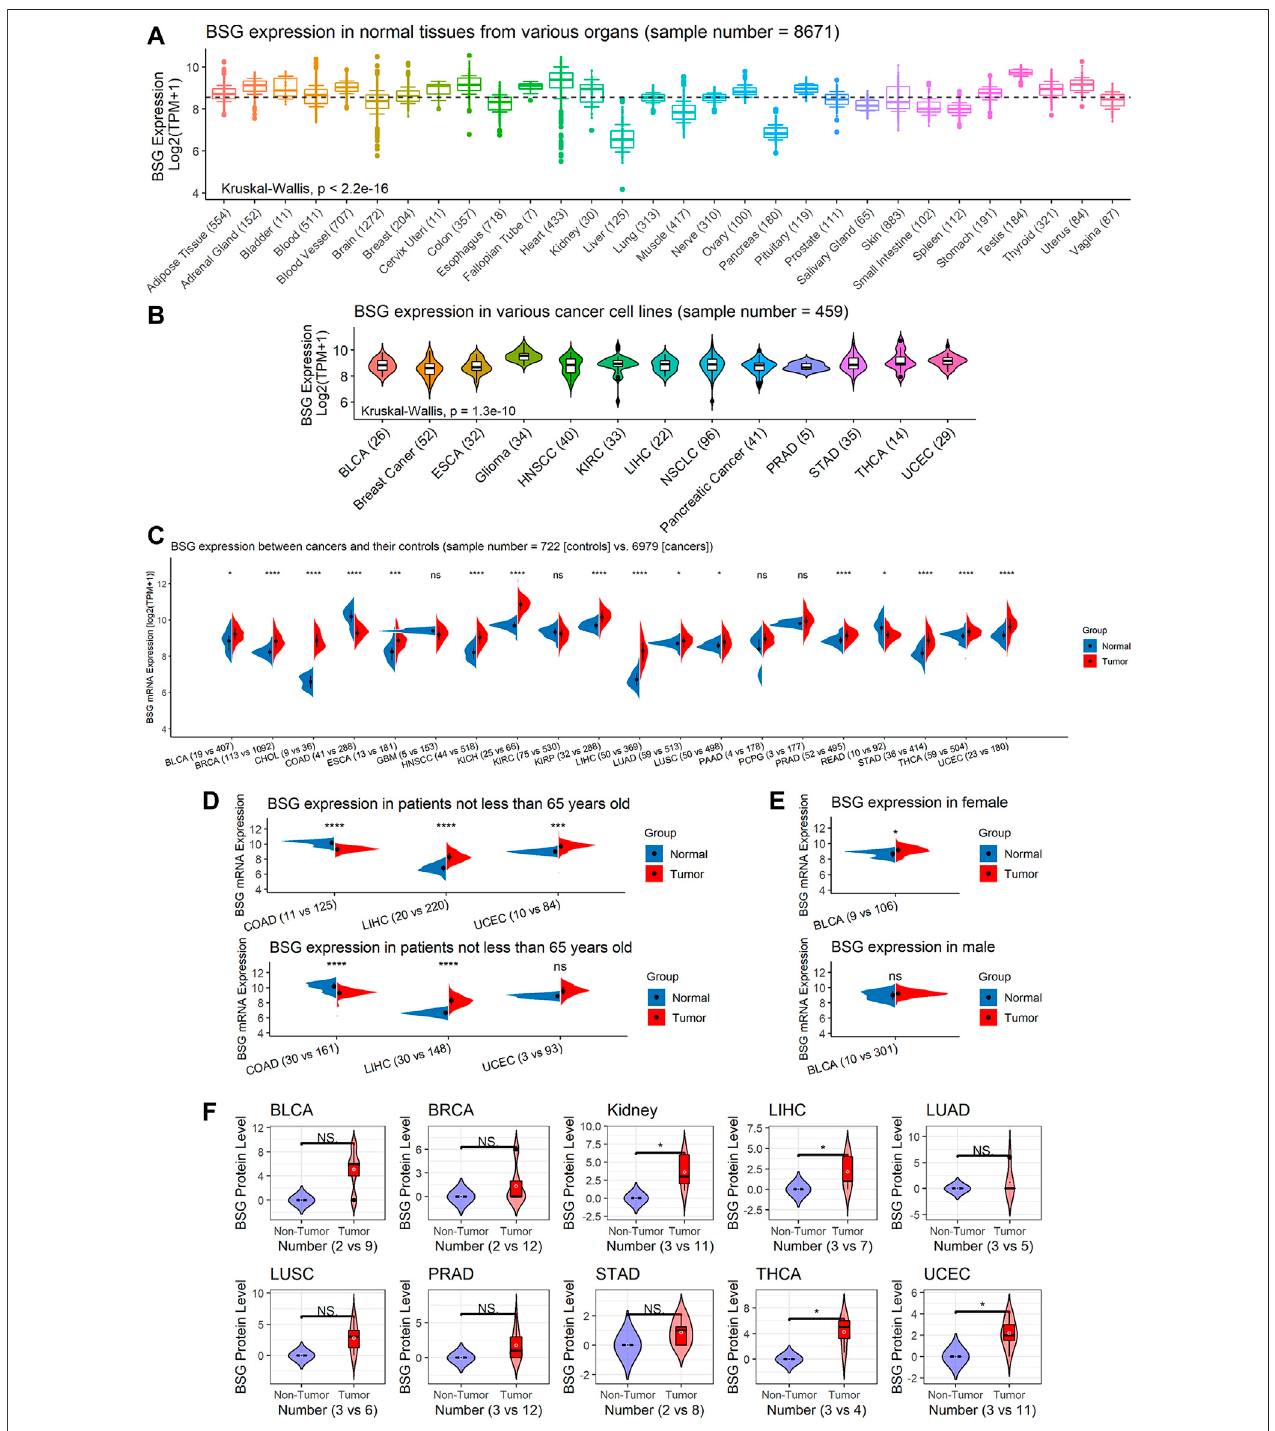
FIGURE 2 | BSG expression in normal tissues and pan-cancer at mRNA and protein levels. (A) Distinct BSG expression in various normal tissues of humans; the dashed linerepresents theaveragevalue(equalingto8.549)ofBSGexpressioninallnormaltissuesshowninthispanel. (B) DifferentBSGexpressionsinvarious cancer cell lines ofhumans. (C) DifferentBSG expressions between cancer tissueswith their normal tissues. (D – E) Hierarchical analysis ofBSGexpression differencesin some cancers and their control tissues. (F) Elevated BSG levels in several cancers were validated at the protein level. In (A,B) , the value in parentheses represents the numberofsamples.In (C – E) ,thetwovalues(e.g., “ n=19vs.407 ” forBLCA)inparenthesesrepresentthenumbersofcontrolsandcancers,respectively.In (C – F) ,each p -value in this fi gure is based on the Wilcoxon rank-sum test, and then p -values in (C – E) are adjusted by multiple comparisons with the false discovery rate method;